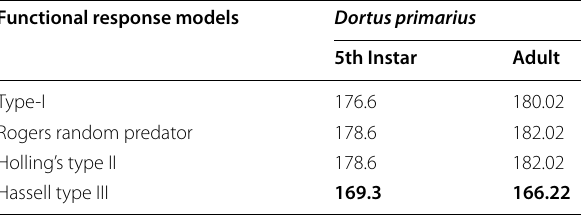
Table 2 Functional response: Akaike Information Criterion (AIC) of four functional response models fitted for 5th-instar nymph and adult female of Dortus primarius when fed on Frankliniella schultzei larvae